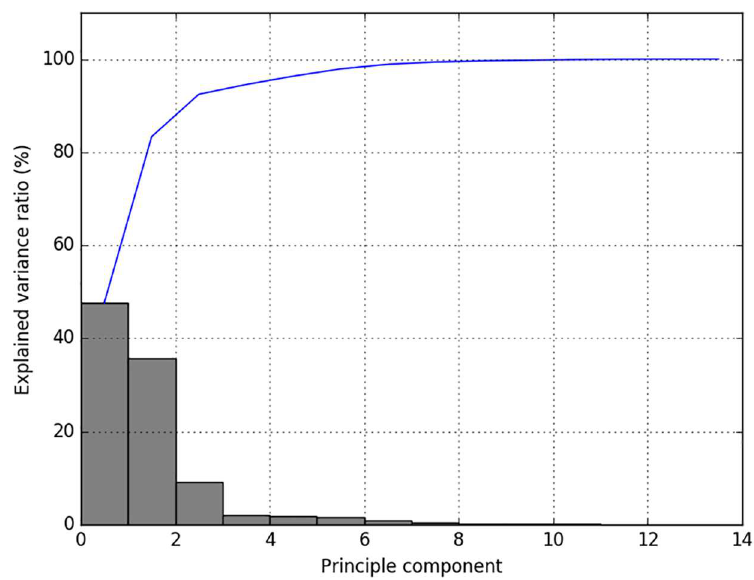
Fig 2. Explained varianceratio as a function of number of principle